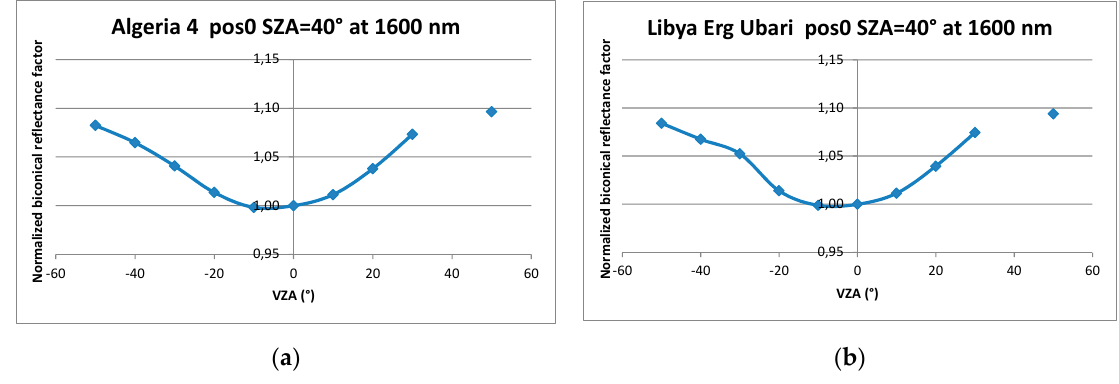
Figure 20. Normalized BCRF for Algeria4 ( a ) and Libya Erg Ubari ( b ) in the principal plane.